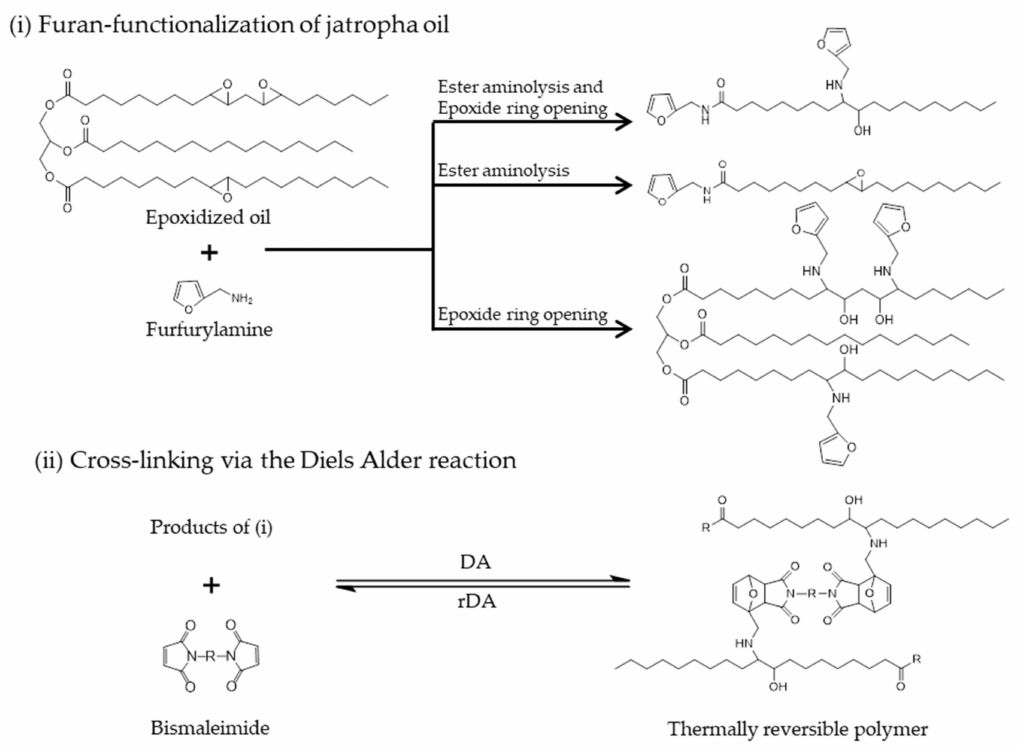
Figure 1. The proposed synthesis route for thermally reversible polymers from epoxidized jatropha